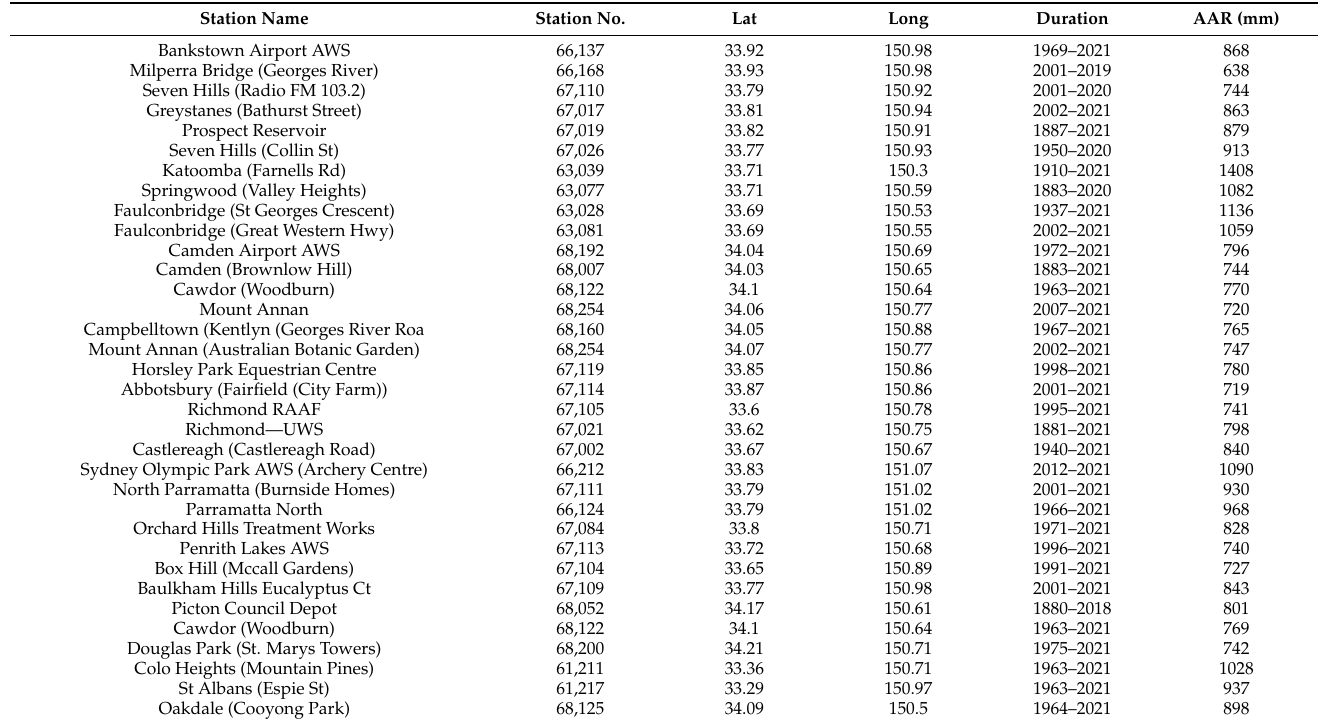
Figure 1. Study area map showing Greater Sydney Region. Table 1. Summary of selected rainfall stations